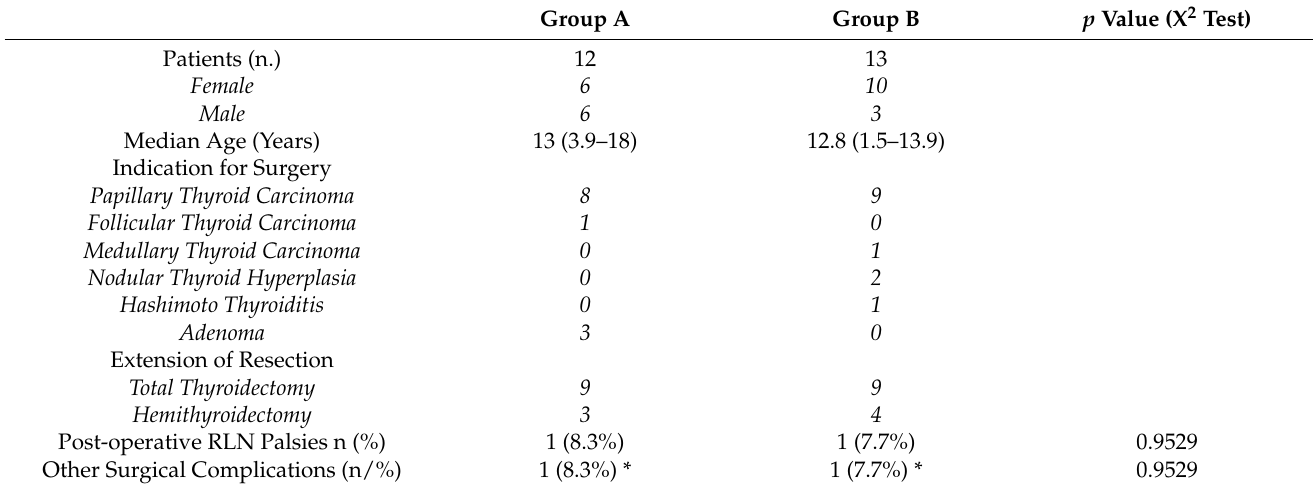
Table 1. Patients’ Demographics, Surgical Procedure and IONM